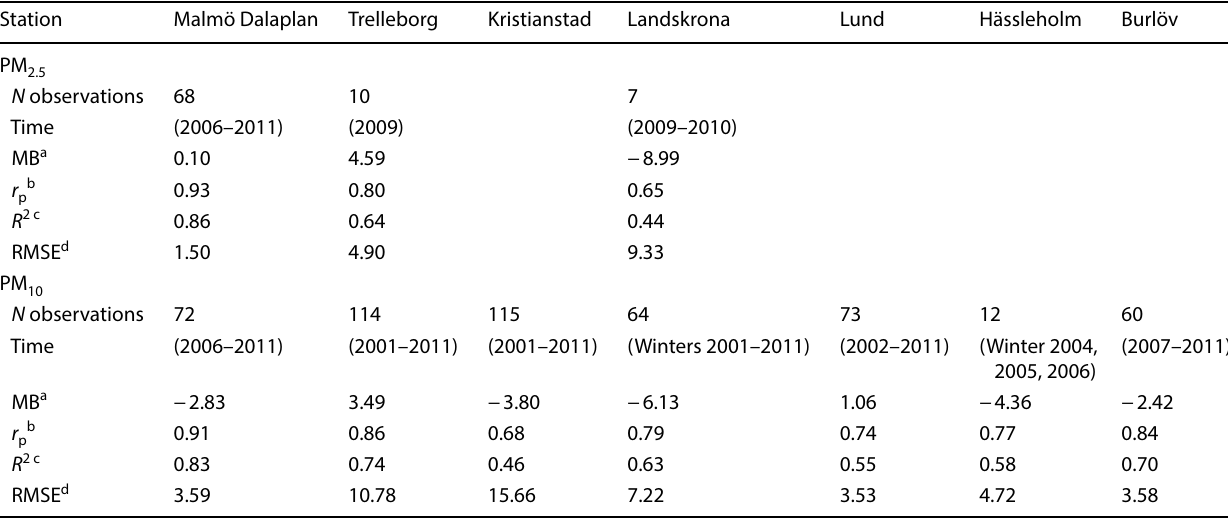
Table 3 Statistical comparison between measured and modelled concentrations of particulate matter (PM) as monthly